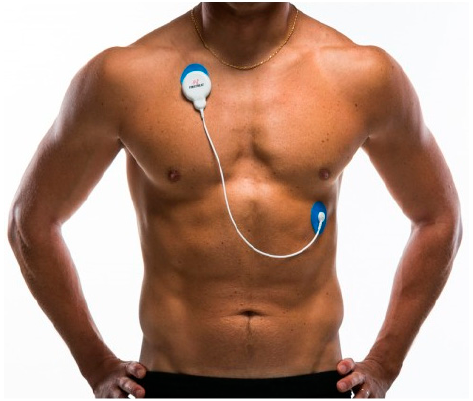
Figure 3. Firstbeat Bodyguard 2 (image used with permission from Firstbeat [38]).